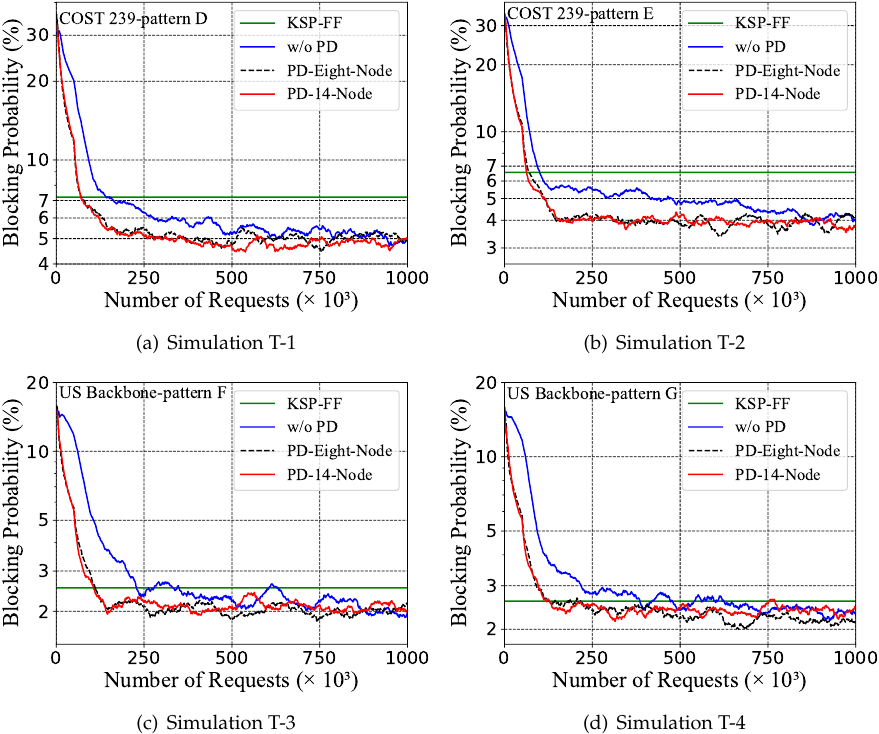
Figure 6. Blocking probability of different topologies with different non-uniform traffic patterns.